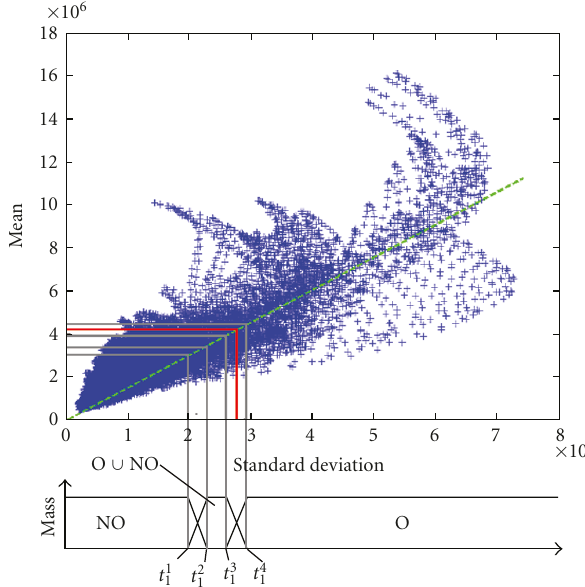
(cid:6) Figure 7: Definition of the mass functions for the first two-order statistical parameters: t 2 1 − t 1 1 = t 4 1 − t 3 1 = V ( (cid:9) σ W ) (the thresholds obtained from the automatic segmentation are in red. The mean standard deviation graph given on this figure has been calculated on the image presented on Figure 20(a)).